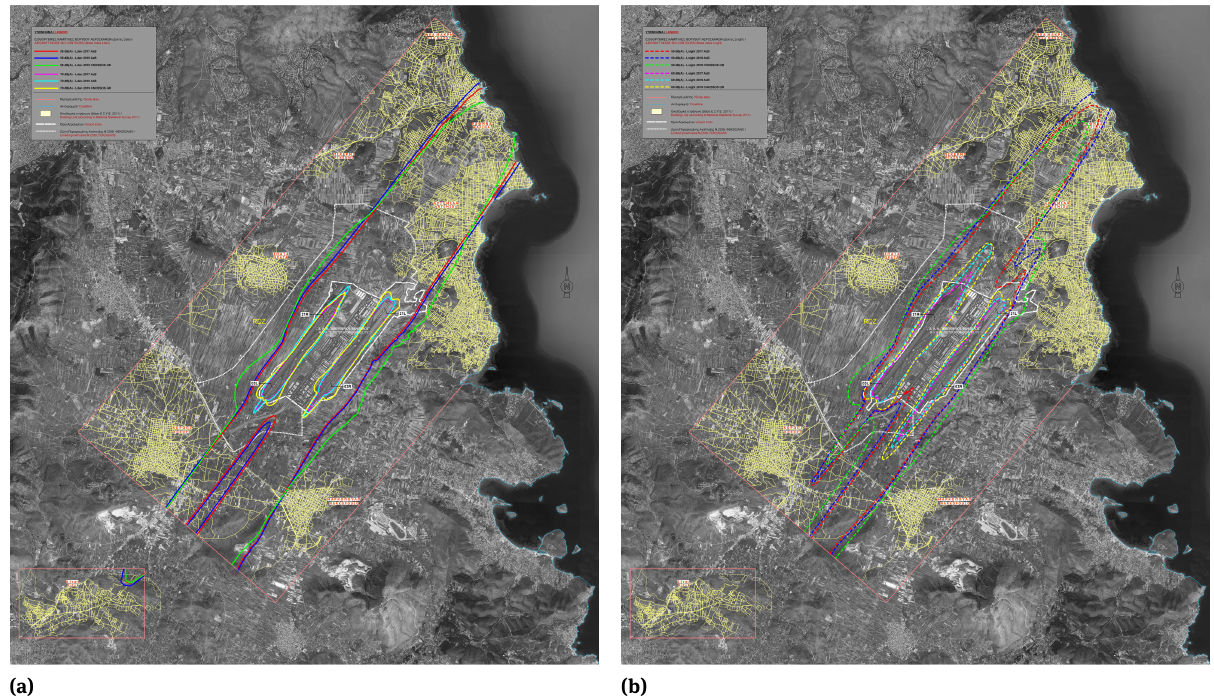
Figure 7: Comparison of SNM 2017, 2019 (ECAC) & 2019 (CNOSSOS-GR) (a) L den 55 dB(A) & 70 dB(A), (b) L night 50 dB(A) & 60 dB(A)